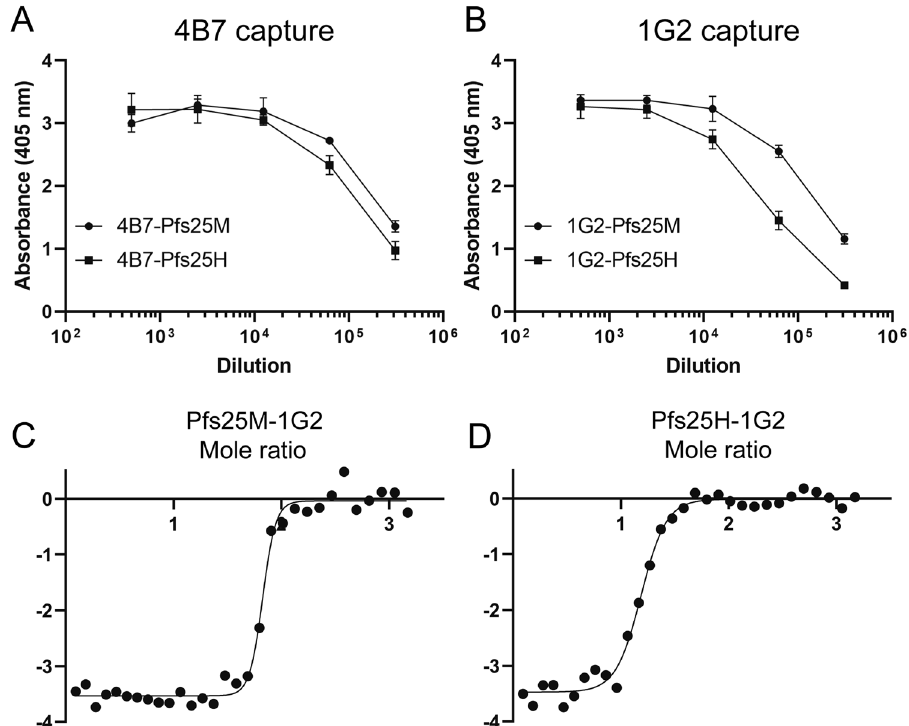
Fig. 3 Evaluation of Pfs25 speci fi c mAbs 4B7 or 1G2 binding Pfs25H and Pfs25M in solution by solid phase or by isothermal titration calorimetry with 1G2. MAbs 4B7 (A ) and 1G2 ( B ) were plated and incubated with Pfs25H or Pfs25M in solution followed by detection with rabbit Pfs25M speci fi c sera and a species-speci fi c secondary reagent. Isothermal titration calorimetry for mAb 1G2 binding to Pfs25M ( C ) or Pfs25H ( D ). The binding constants, Kd, for Pfs25M and Pfs25H were 6.3 × 10 − 9 and 4.1 × 10 − 8 , respectively. Symbols and error bars in A and B represent the mean and standard